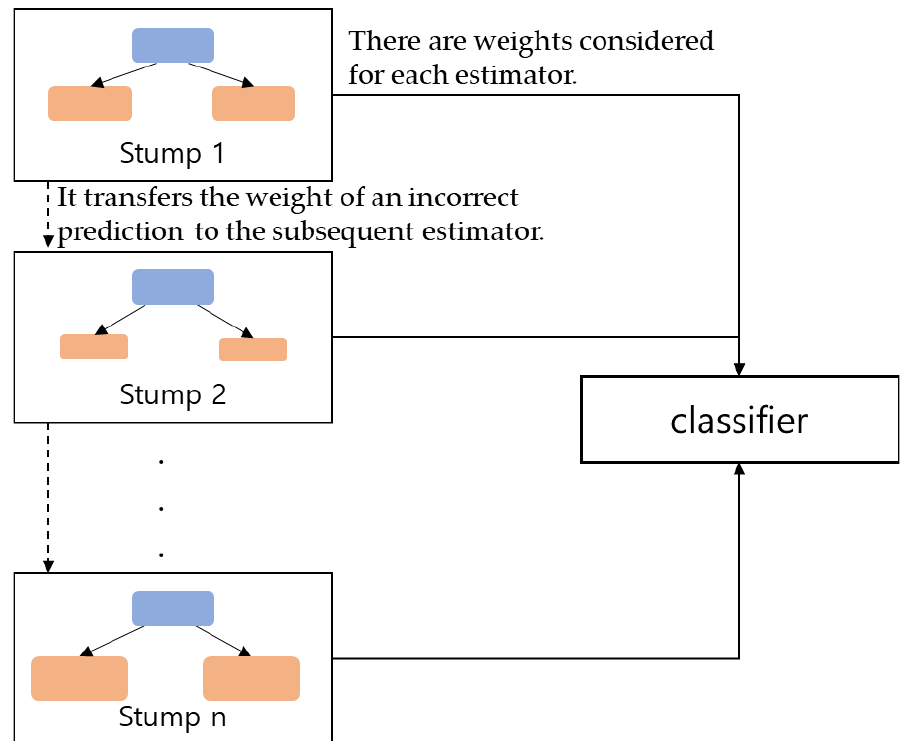
Figure 11. Processing of adaptive boost. Each estimator transfers the weight of an incorrect prediction after training via the dataset.